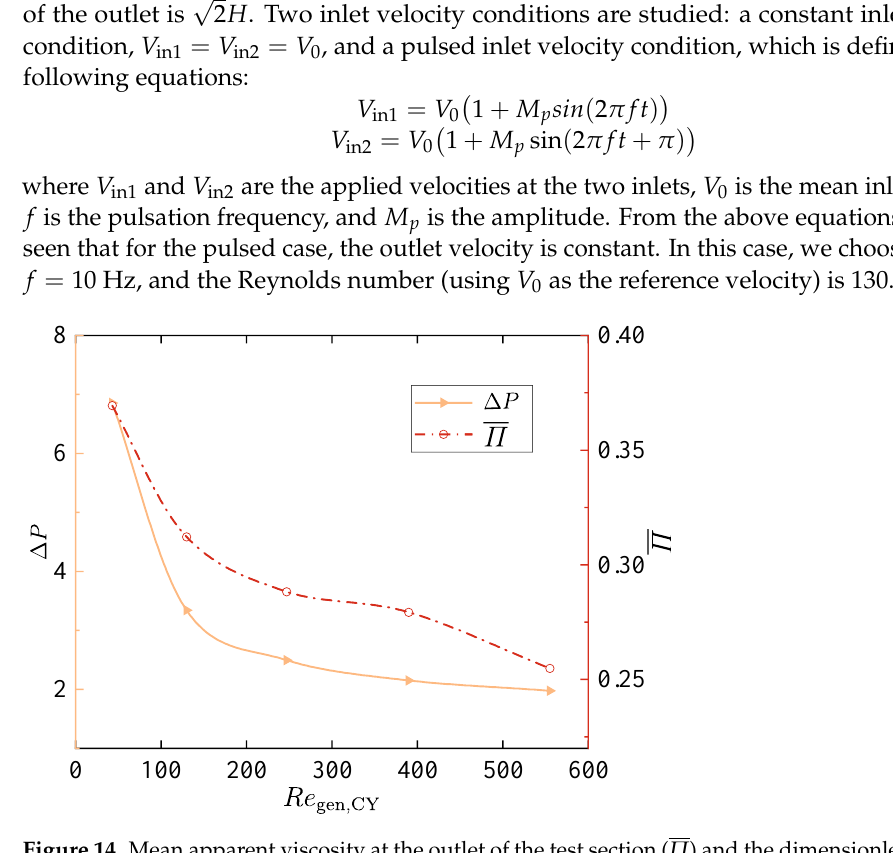
Figure 14. Mean apparent viscosity at the outlet of the test section ( Π ) and the dimensionless pressure drop of the test section ( ∆ P ) for different Re gen,CY . The length of the wave is 2 H , and the amplitude of the wave is 1/5 H .